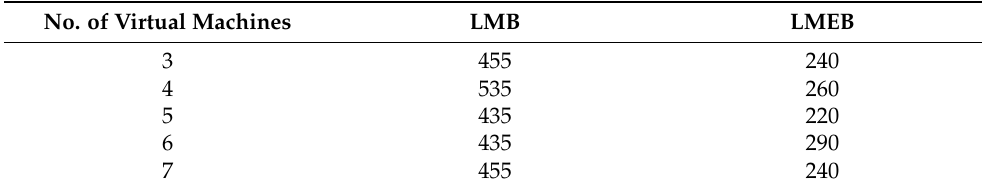
Table 9. Migration time for all scenarios in